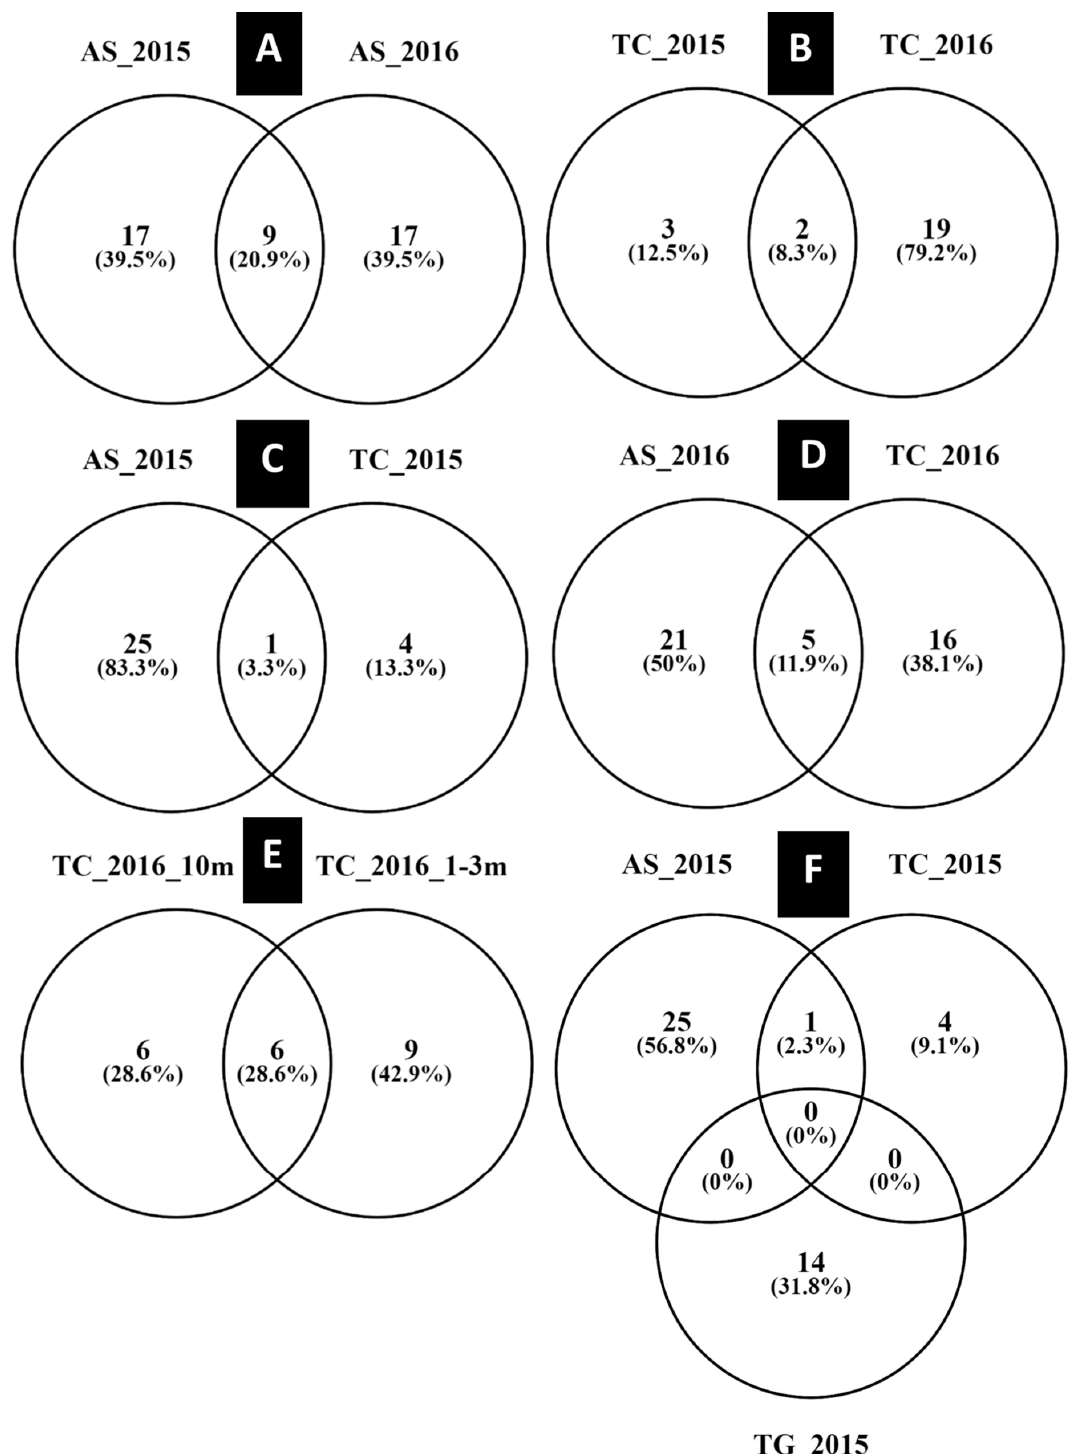
Figure 5. Venn diagrams of the ectomycorrhizal communities (based on OTUs) of A . spirorbis and Tristaniopsis species, in relation to host and year. Data are presented in multiple ways, as follows: (i) evolution of OTUs from 2015 to 2016 in A . spirorbis ( A ) and T . calobuxus ( B ), (ii) shared and unique OTUs between A . spirorbis and T . calobuxus in 2015 ( C ) and 2016 ( D ), (iii) shared and unique OTUs found between T . calobuxus planted inside a 3 m radius around A . spirorbis , versus T . calobuxus planted in square plots at 10 m away from A . spirorbis ( E ), and (iv) the shared and unique OTUs at the beginning of the experiment in 2015, between A . spirorbis , T . calobuxus , and T . guillainii ( F